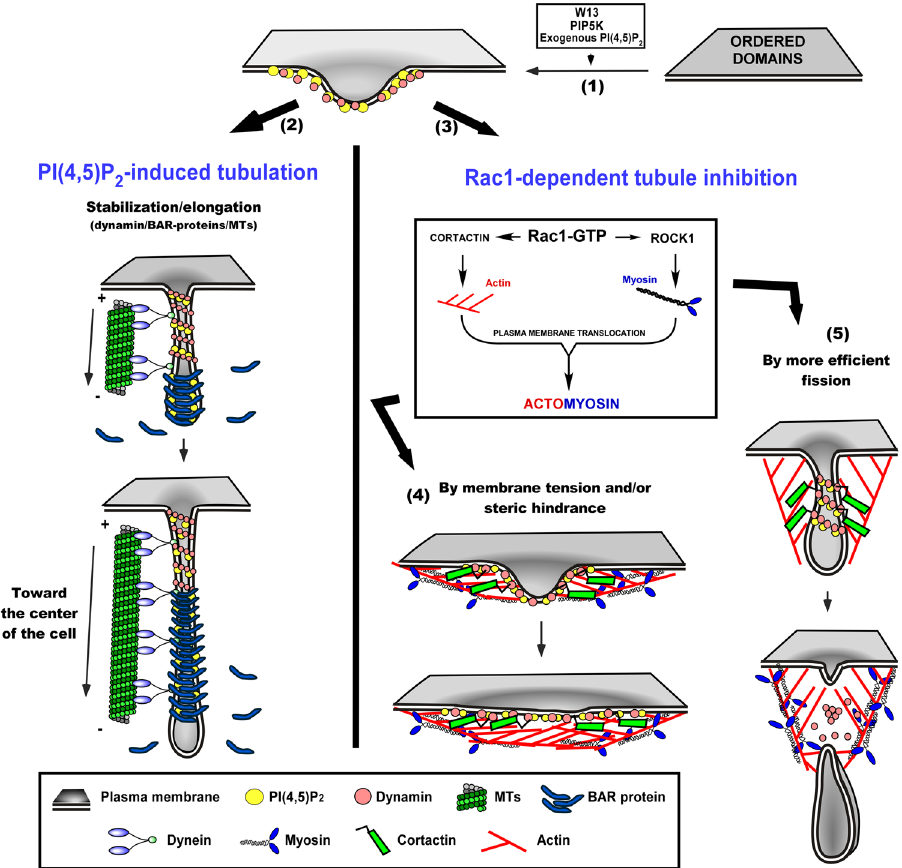
Figure 8. Molecular machinery implicated in the biogenesis and inhibition of PI(4,5)P 2 -induced endocytic tubulation. An increase of PI(4,5)P 2 in PM ordered domains could induce the recruitment of several PI(4,5) P 2 -binding proteins to generate an incipient membrane deformation (1). When Rac1 activity is low (2), the invagination can be elongated by dyneins toward the center of the cell along microtubules. PI(4,5)P 2 accumulation, as well as the high degree of membrane curvature, could lead to the recruitment of dynamin or BAR-domain proteins, which in turn, could propagate and stabilize the tubule. By contrast, when Rac1 activity is high, tubulation process could be inhibited by either PLC activation (reducing PIP 2 levels) or cytoskeleton regulation (inducing cortical actomyosin at the PM) (3). Rac1 appears to stimulate cortactin PM translocation and ROCK1 activity, thereby triggering cortical actin polymerization and association with myosin (i.e., actomyosin). The resulting over-activation of local actomyosin networks could potentially impede tubulation in one of two ways: (i) by forming a local barrier to increasing PM tension or by causing a steric hindrance that impedes the recruitment of tubulating proteins (4); or (ii) by generating mechanical forces needed to pinch off membrane invaginations more efficiently